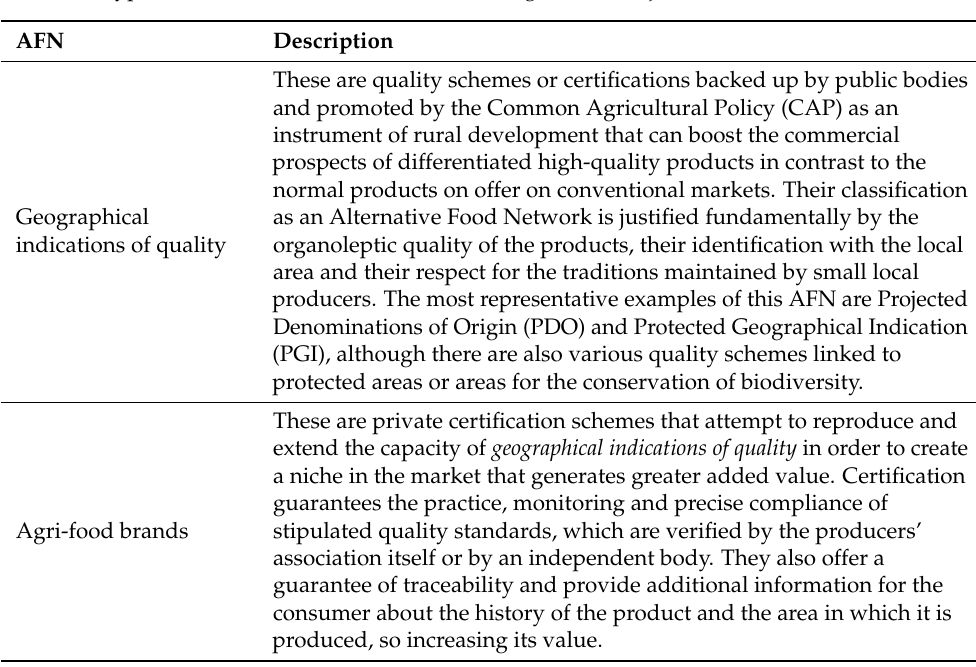
Table A1. Types of AFNs Identified in the Selected Agri-Food Projects.